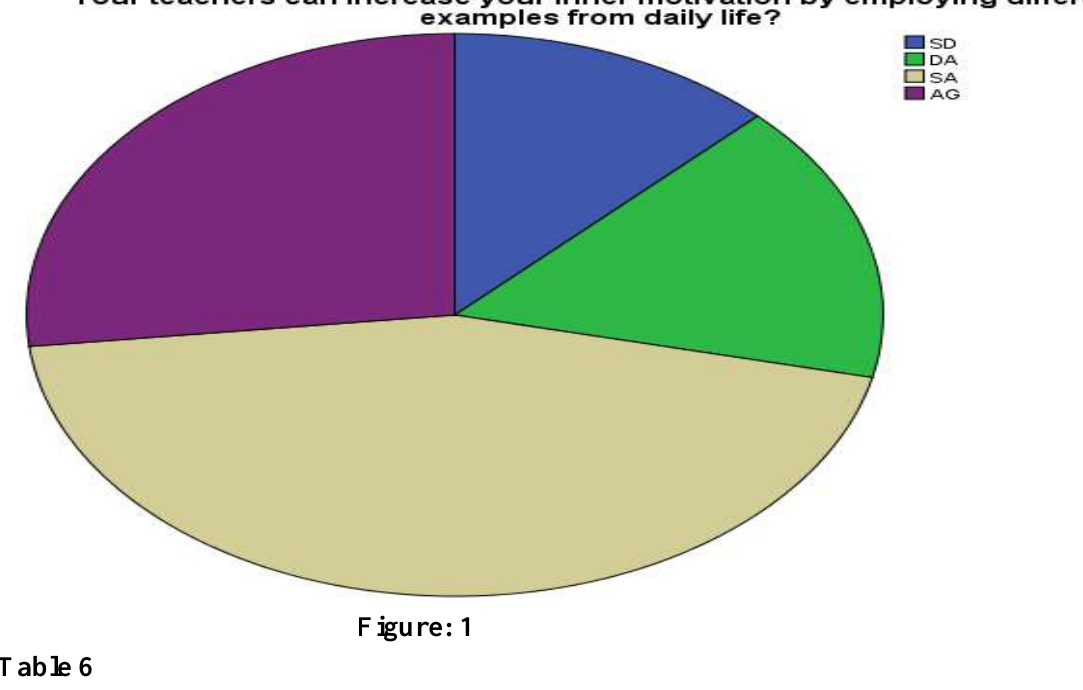
Classroom environment plays a great role in learning?